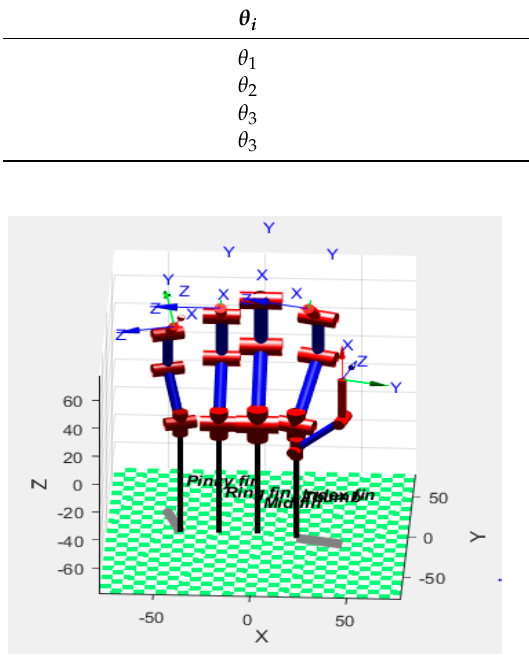
Figure 6. Forward kinematics of the entire hand .